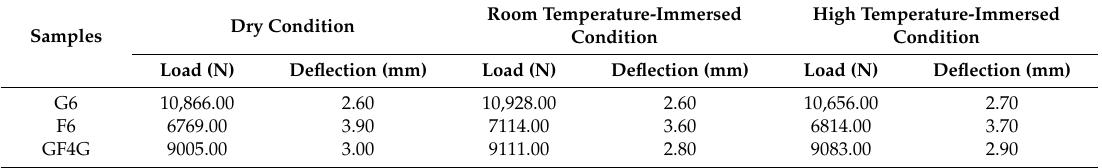
Table 2. Maximum load and maximum deflection of dry samples and two condition wet samples.